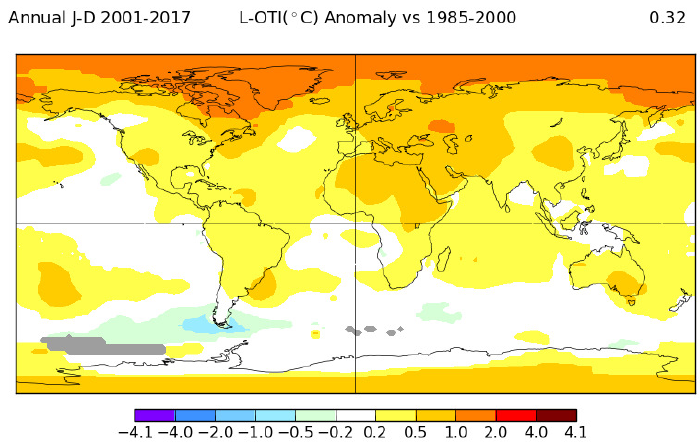
Figure 6. NASA GISS T change from 1985–2000 to 2001–2017.